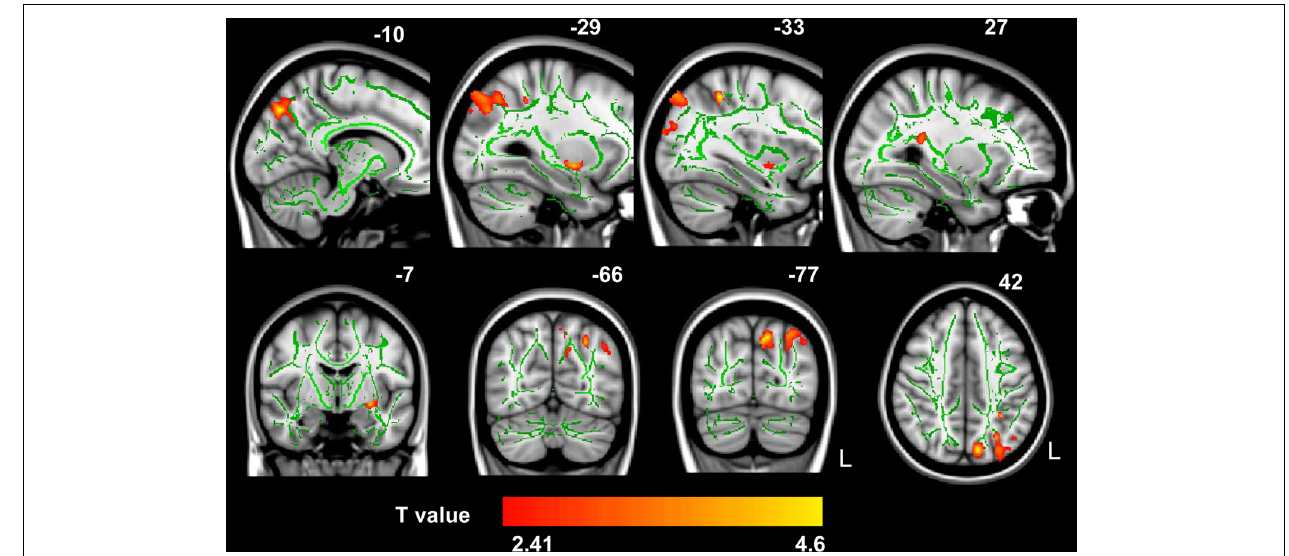
FIGURE 3 | The correlation between FA values and WISC-RC arithmetic scores. Positive correlation between FA values and WISC-RC arithmetic scores in the left SLF, ILF, and bilateral IFOF. The location of the significantly correlated cluster was shown in red-yellow. The color intensity represents the T-statistical value at the voxel level. The statistical threshold was set at